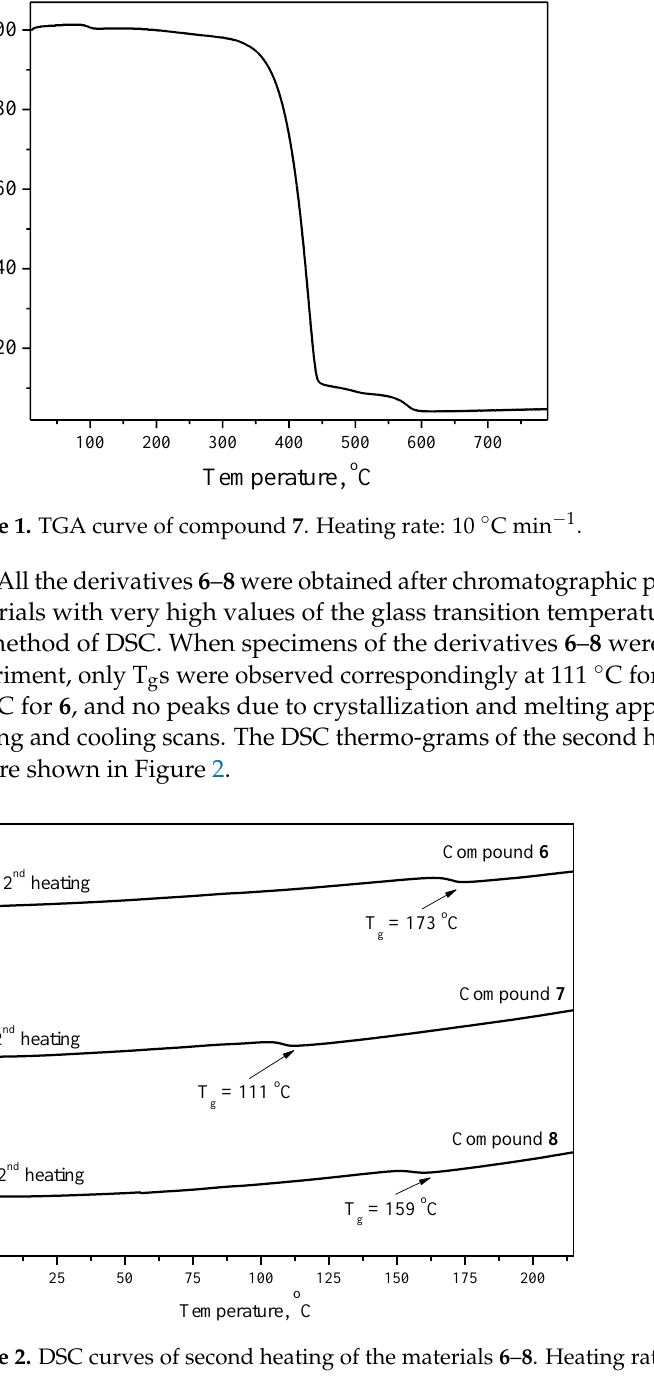
Figure 2. DSC curves of second heating of the materials 6 – 8 . Heating rate: 10 °C·min −1 .